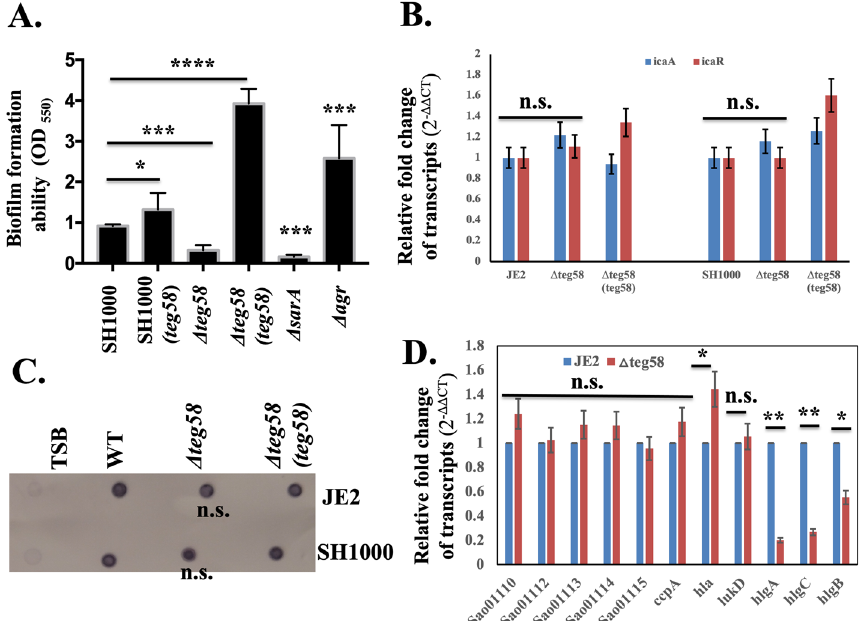
Figure 3. teg58 mediated biofilm formation is independent of PIA production and regulation of the target genes. ( A ) Static biofilm assay with isogenic strains in SH1000 background in TSB plus 0.25% glucose for 24 h. The sarA and agr mutant strains were used as controls. Δ teg58 , 220 bp chromosomal deletion strain; Δ teg58 ( teg58 ), teg58 mutant complemented with pSK236 containing 450-bp teg58 with its native promoter. Means and standard deviations from triplicate experiments are shown. Student t -test (* P < 0.05, *** or ****P < 0.001). ( B , D ) Real-time qRT-PCR analysis for various genes as indicated along with the rpoB control were evaluated by qRT-PCR (2 −ΔΔCT ) using total RNA isolated from the respective strains at 24 h grown biofilm cells in TSB. The data were normalized against rpoB as the reference transcript for qRT-PCR. Relative expression of the genes was plotted against the wild type set as 1.0. “n.s.” indicate “not significant”. Pairwise comparation with Student t -test (* P < 0.05, **P < 0.005). ( C ) Dot bot showing PIA production in various strains. PIA production was detected with an anti- S. aureus PIA antibody, showing no changed in PIA production due to